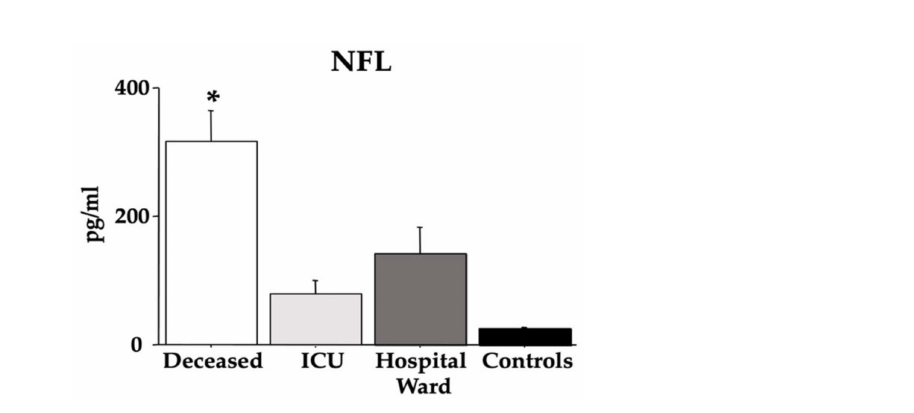
Figure 3. Serum NFL in COVID-19 patients. The error bars indicate pooled standard error means (SEM) derived from the appropriate error mean square in the ANOVA. The asterisk ( p < 0.05) indicates post hoc differences between the deceased group and ICU , hospital ward , and control individuals.